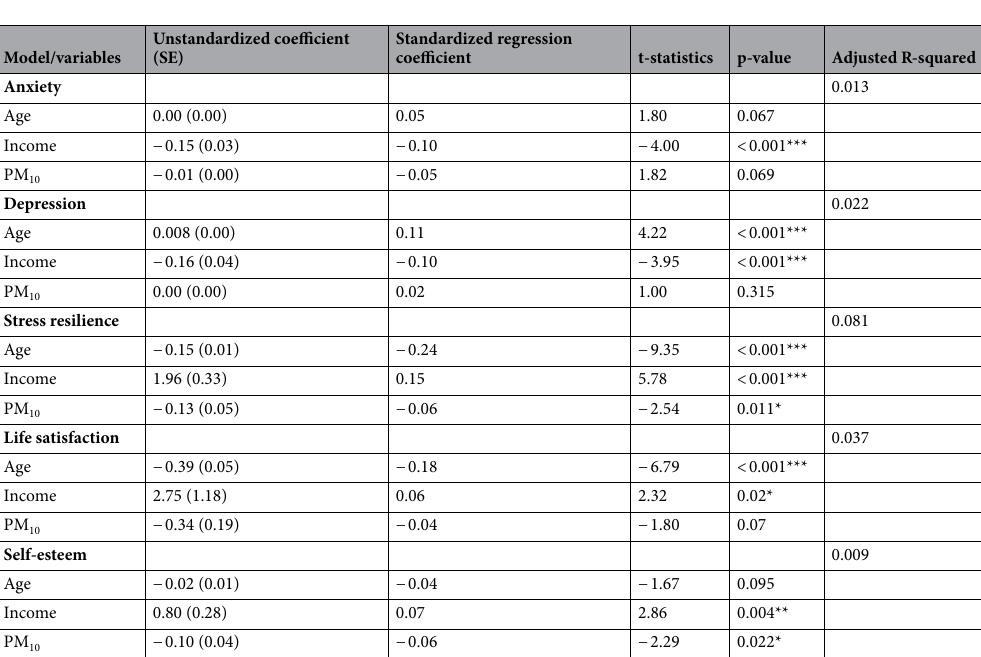
Table 4. Regression analyses predicting mental health and well-being determinants for females. Dependent variables anxiety, depression, stress resilience, life satisfaction and self-esteem. PM 10 particulate matter 10 µg/ m 3 , SE standard error. *p < 0.05, ** p < 0.01, *** p <